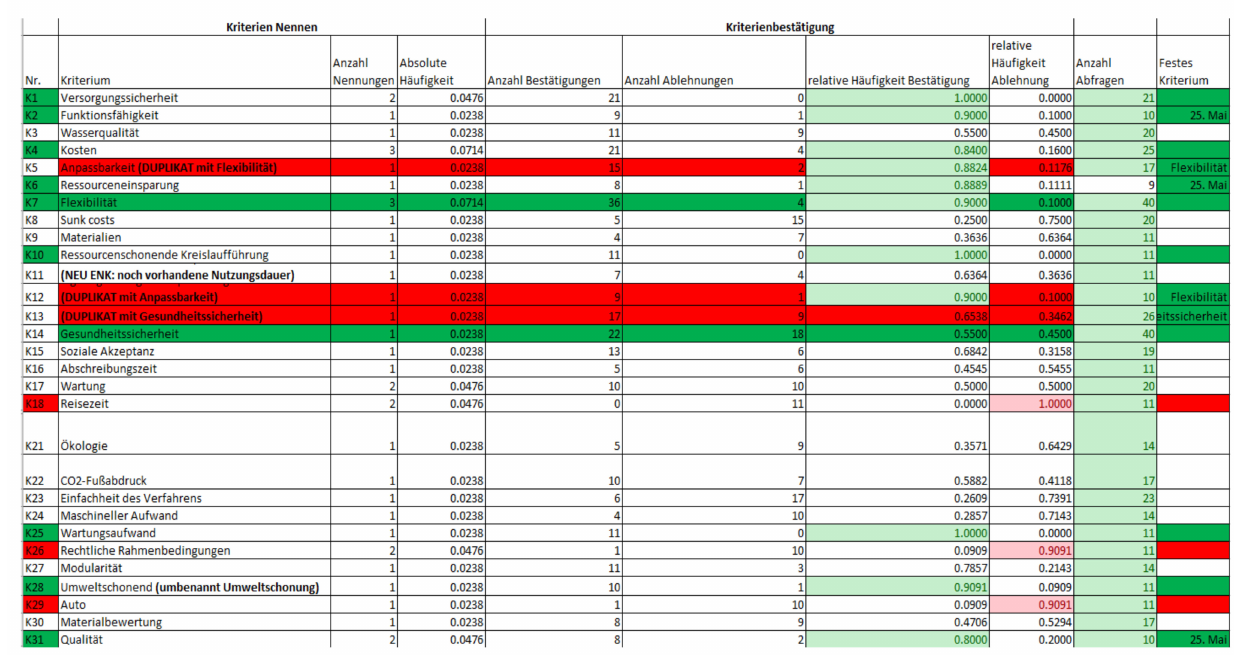
Figure 7. Excerpt from the spreadsheet-hold SOO